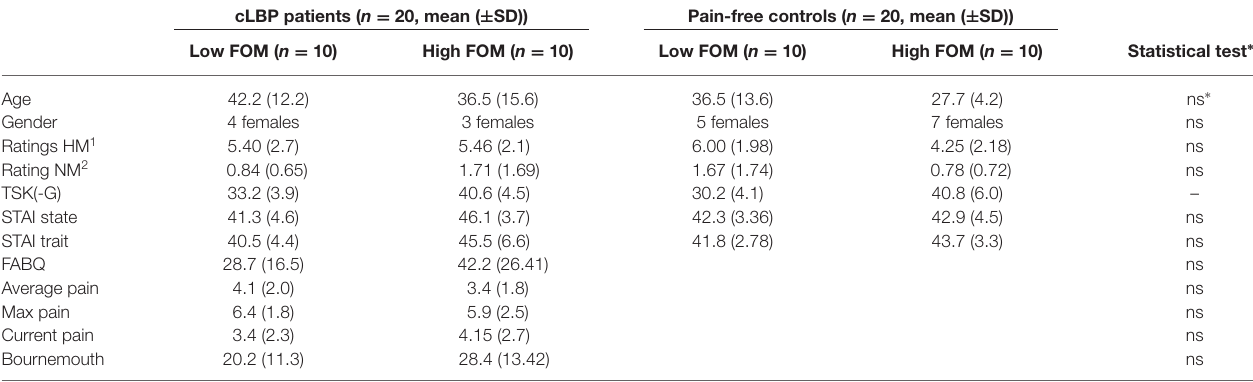
TABLE 1 | Participants